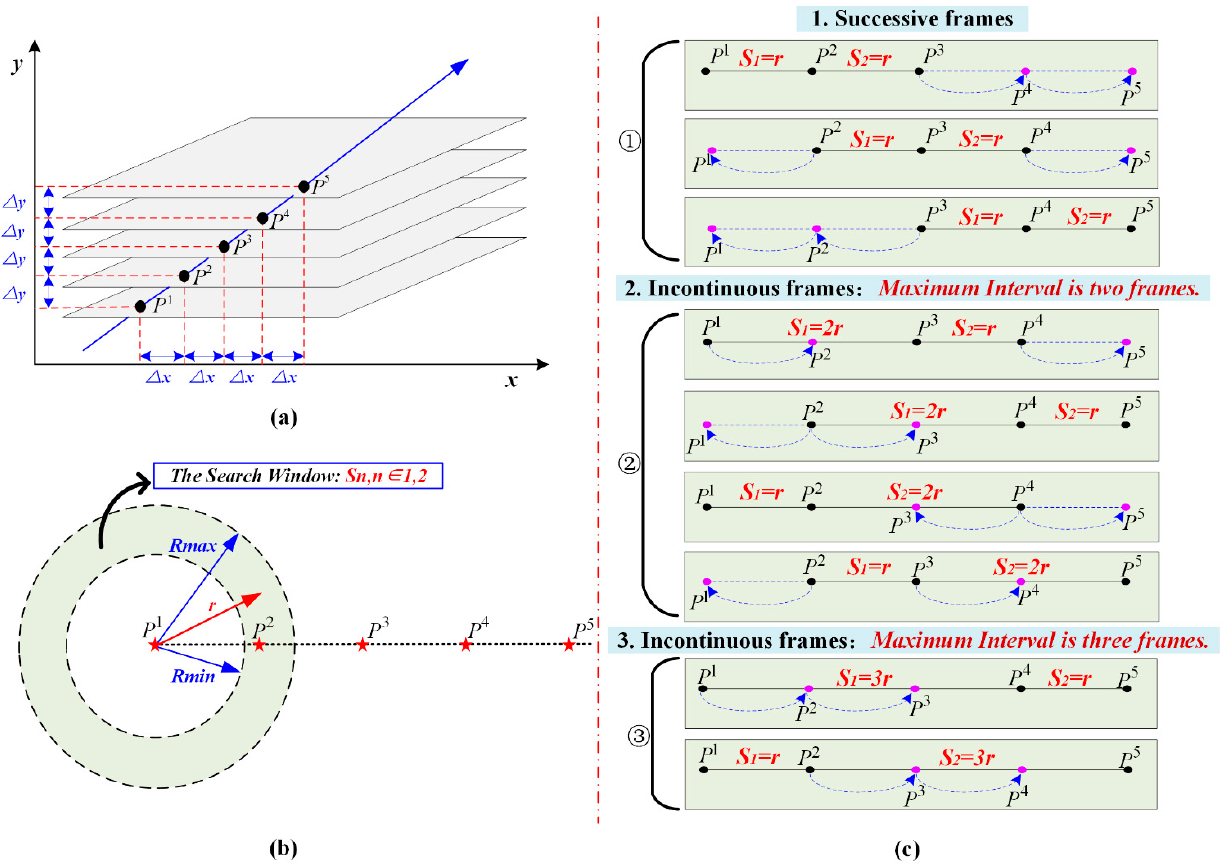
Figure 8. The schematic diagrams of three steps in the proposed CFS strategy: ( a ) a schematic view of the line in space-time intersecting image planes in a discrete ordered set of locations; ( b ) the ringlike search window; ( c ) the enumeration of potential candidate targets of sequence-based detection results.